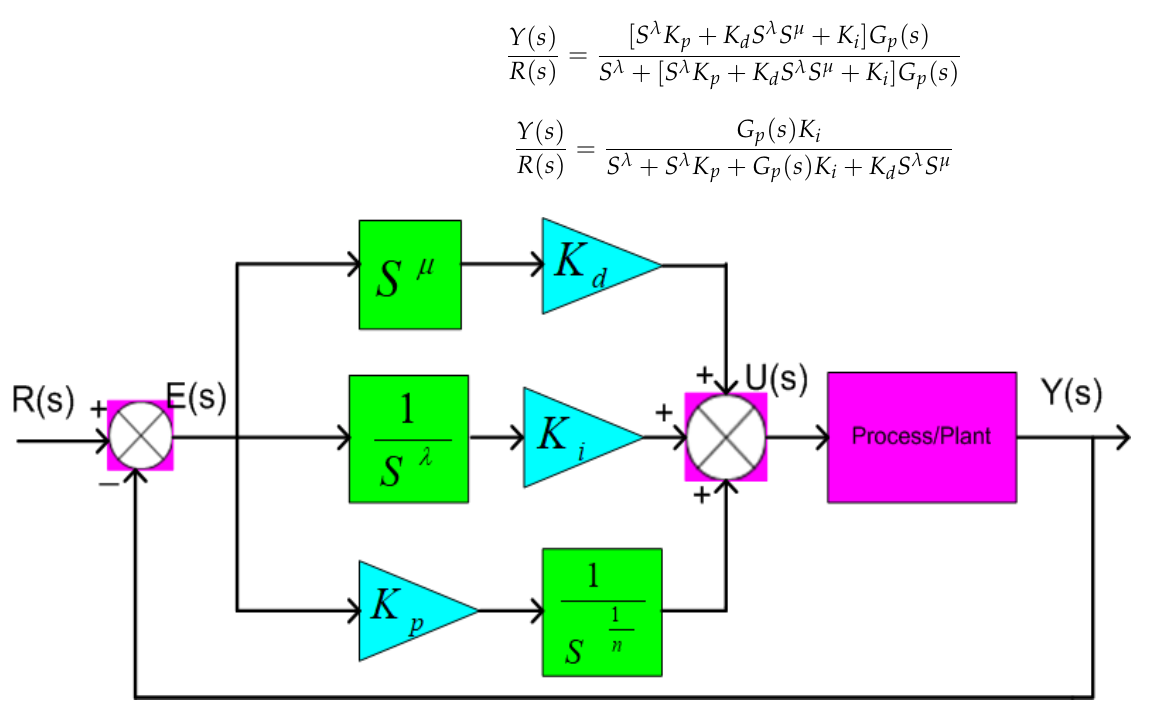
Figure 5. Structure of FOPID controller.